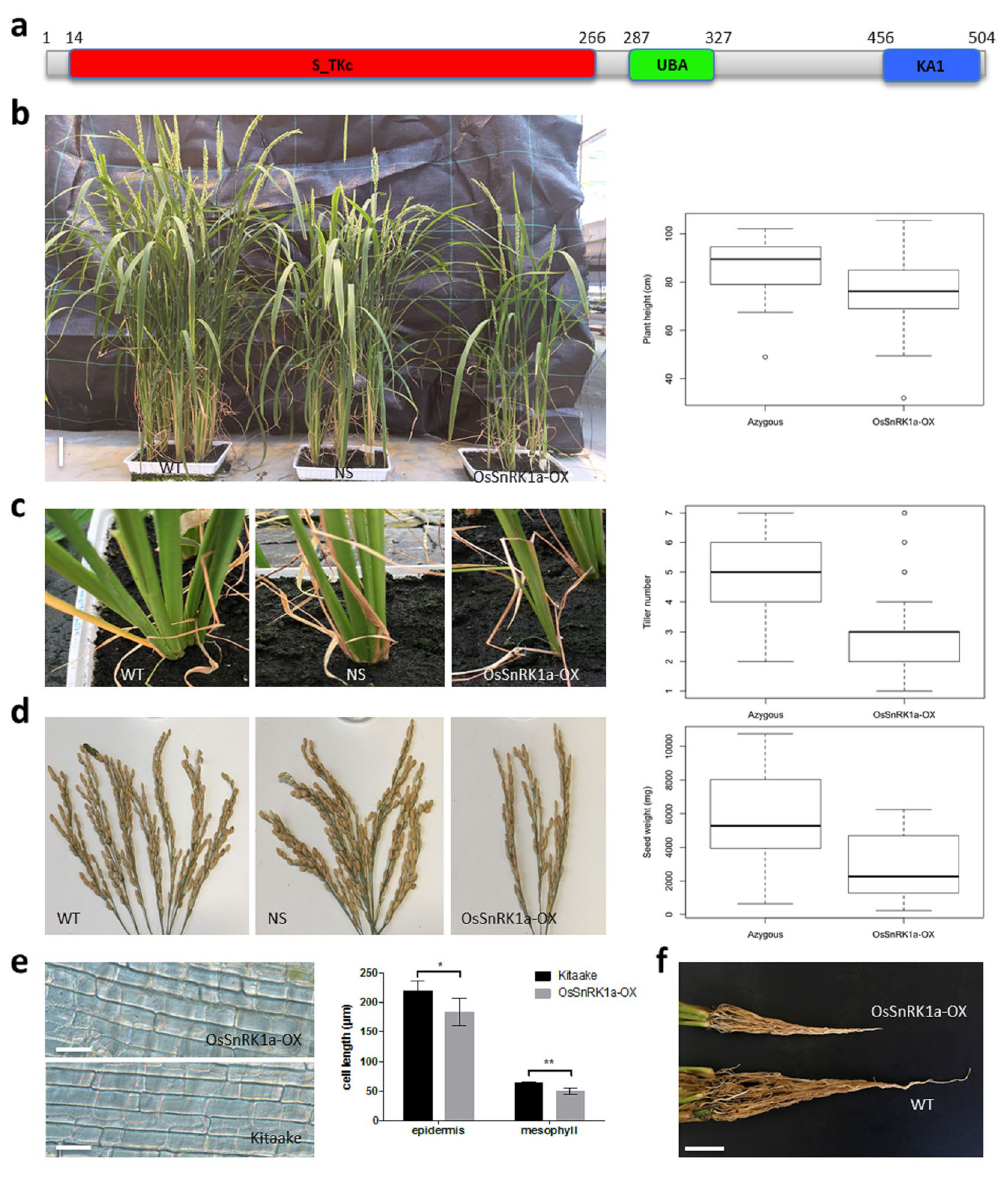
Figure 1. OsSnRK1a overexpression negatively affects plant growth and development. ( a ) Diagrammatic representation of the rice Sucrose Non-fermenting-1 related kinase 1 A (OsSnRK1a). Protein motif and domains of OsSnRK1a were identified using the Simple Architecture Research Tool (SMART) (http://smart. embl-heidelberg.de) and NCBI-CDD. (http://www.ncbi.nlm.nih.gov/Structure/cdd/wrpsb.cgi). S_TKc, Serine/ Threonine protein kinase catalytic domain; UBA, ubiquitin-associated domain; KA1, kinase-associated 1 motif. ( b ) to ( f ) Phenotypes of T1 OsSnRK1a overexpressing transgenic rice plants. Azygous controls = null segregants (NS, progeny of lines OsSnRK1a- OX 13–2, 17–4) and Kitaake wild type (WT). OsSnRK1a- OX = progeny of OsSnRK1a -overexpressing lines 5-1, 5-3, 9-5, 10-5, 14-2, and 14-8. When 12 weeks old, plants were scored for several growth parameters. Overexpression of OsSnRK1a inhibited ( b ) plant growth, ( c ) tiller number, ( d ) seed yield, ( e ) epidermal and mesophylic cell elongation, and ( f ) root growth. Box plots in ( b ) to ( d ) show box and whiskers (Min to Max), open circles represent outliers outside the range of the whiskers. Welsh’s t-test for ( b ), ( c ) and ( d ) revealed significant results with p = 0.001621, p = 0.0005032, and p = 0.001197, respectively. Pictures are representative of the lines in bold. Bars in ( b ), ( e ) and ( f ) are 7 cm, 50 μ m and 3 cm respectively. Pictures in ( d ) show seed yield of a single representative plant at week 13. Asterisks in ( e ) represent significant differences compared to Kitaake plants (Mann-Whitney test, ns = p > 0.05, * p ≤ 0.05; ** p ≤ 0.01; *** p ≤